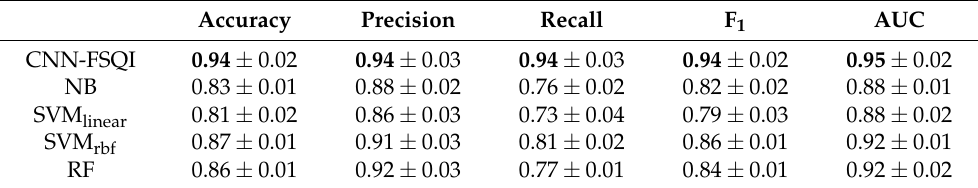
Table 2. Cross-validation results of the proposed model (CNN-FSQI) and the benchmark traditional machine learning models trained with the FSQI features from [31,37]. Bold shows the highest performance per column. [avg. ±